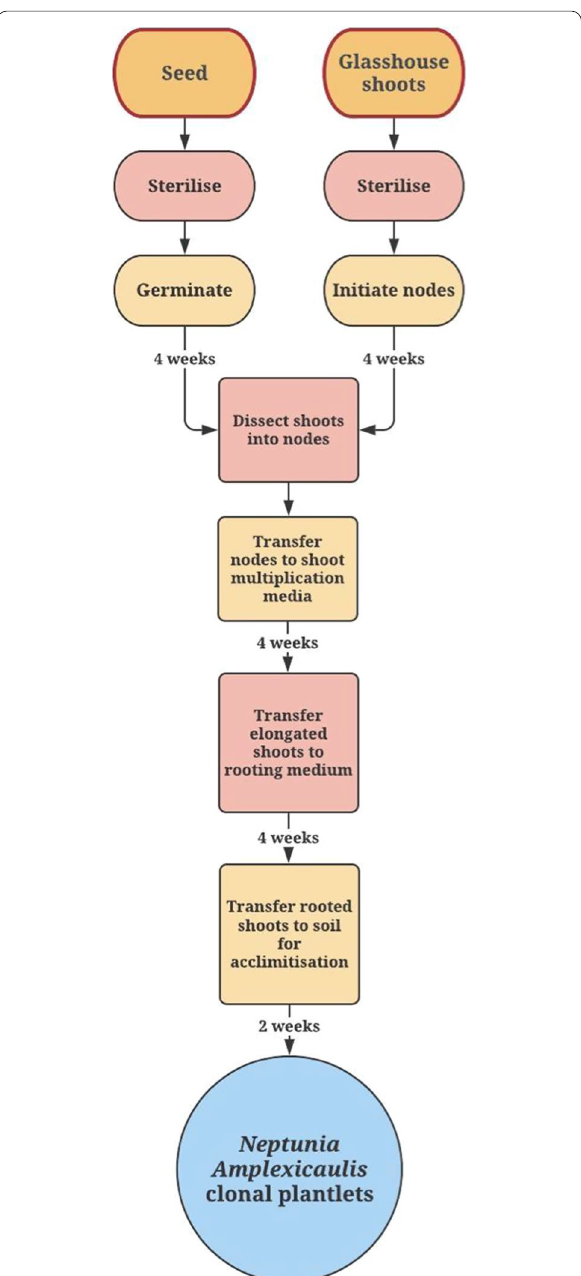
Fig. 6 Flow chart presenting main steps for the nodal culture micropropagation of N. amplexicaulis. Micropropagation from seed shown on the left side and mature nodes are on the right. Steps in which the process is the same for both types of plant material are in the middle of the